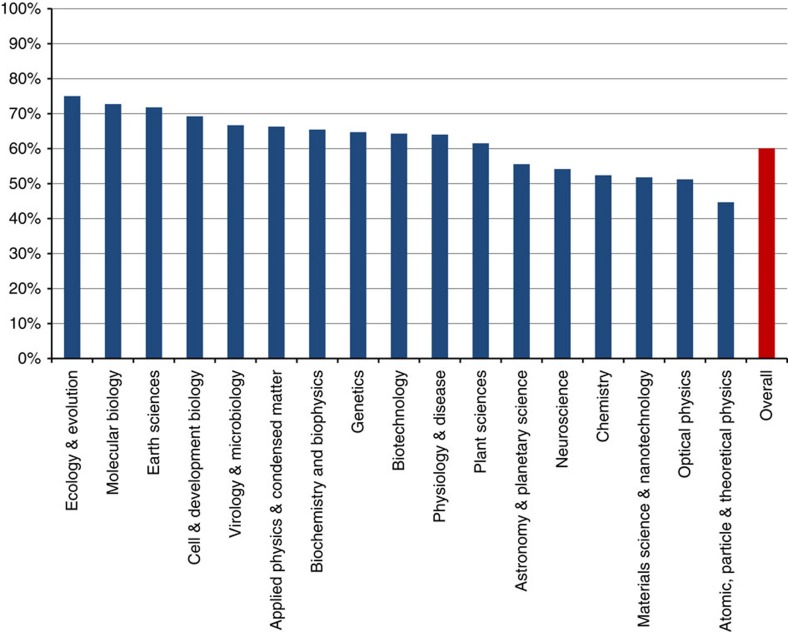
Transparent peer review at Nature Communications.The figure shows the author opt-in rate across the different research areas for 787 published papers. The average opt-in across the journal is about 60%.